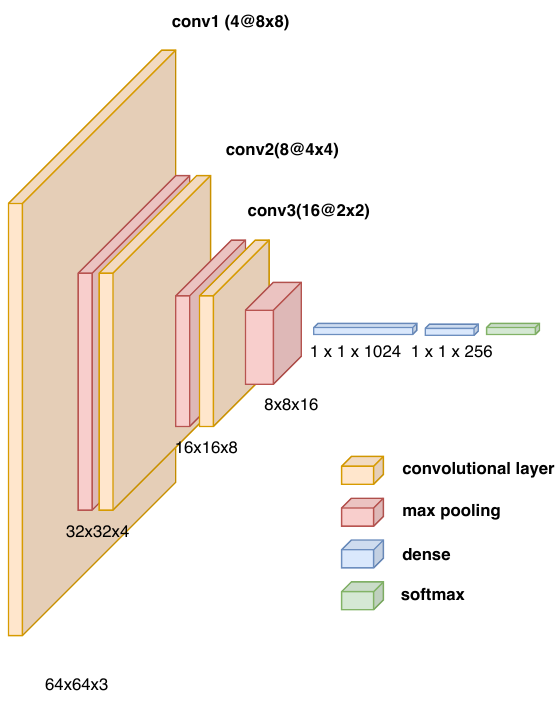
Figure 6. CNN architecture with a 64 × 64 RGB image as the input, three convolutional layers, three max-pooling layers, two dense fully connected layers, and a softmax function at the